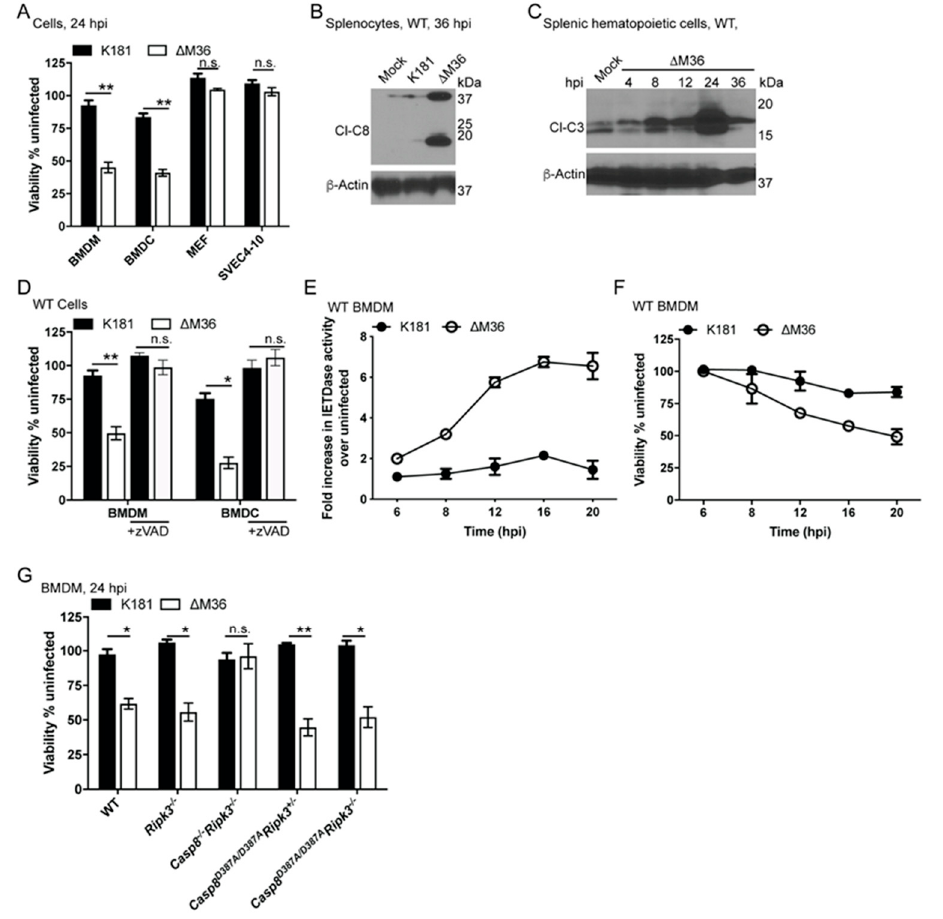
Figure 1. Caspase (CASP)8 activity is required for ∆ M36-induced apoptosis. ( A ) Relative viability of bone marrow-derived macrophages (BMDM), bone marrow-derived dendritic cells (BMDC), murine embryonic fibroblasts (MEF), and SVEC4-10 cells infected for 24 h (h) with K181 or ∆ M36 at MOI